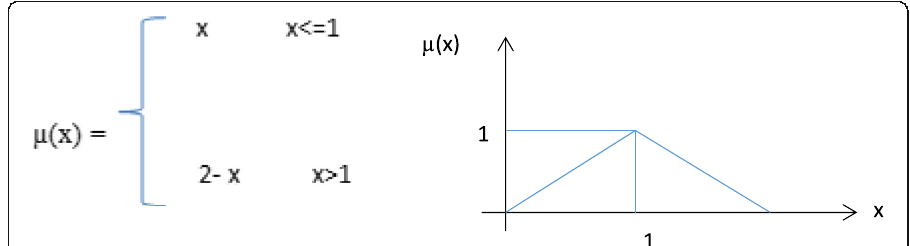
Fig. 7 Membership function of a real number. This Fig is the graphical representation of the membership function of the fuzzy set of real numbers near one. The horizontal axis is number and the vertical axis is the value of the membership. For example, the value of the membership of number one is one